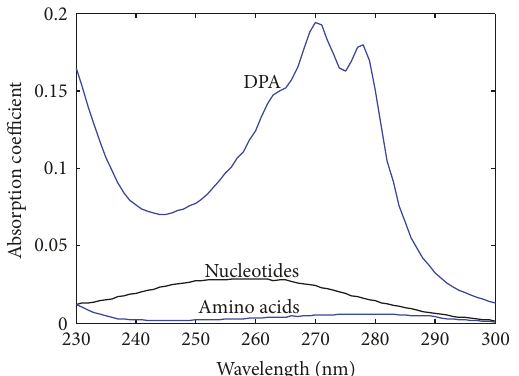
Figure 5: Comparison of the absorption coe ffi cient of total nucleic acid, chromophoric amino acids, and dipicolinic acid weighted by their typical concentration in microorganism [38].